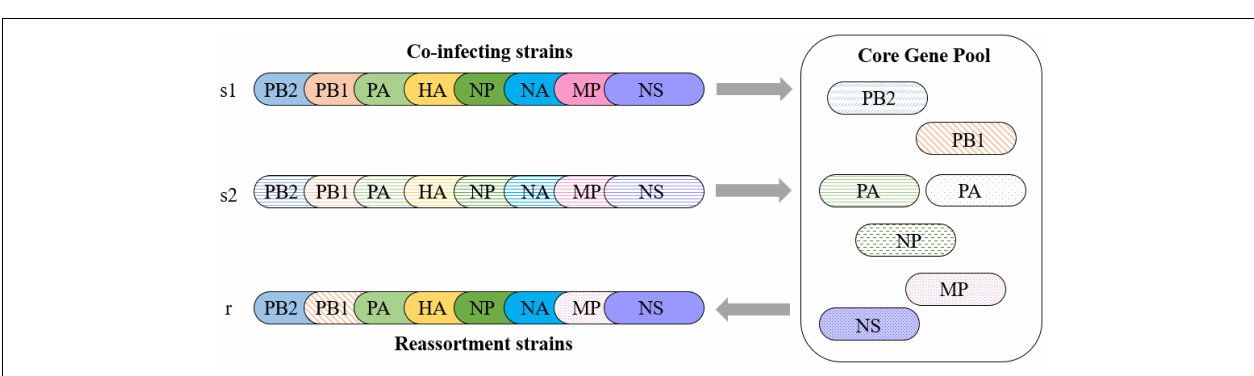
FIGURE 6 | Reassortment pattern of the core gene pool. Two strains, s1 and s2, coinfect a host with the H9N2 virus. Strain s1 obtains PB1 and MP internal segments from the core gene pool and produces a reassortment strain r. Strain s2 provides a new PA for the core gene